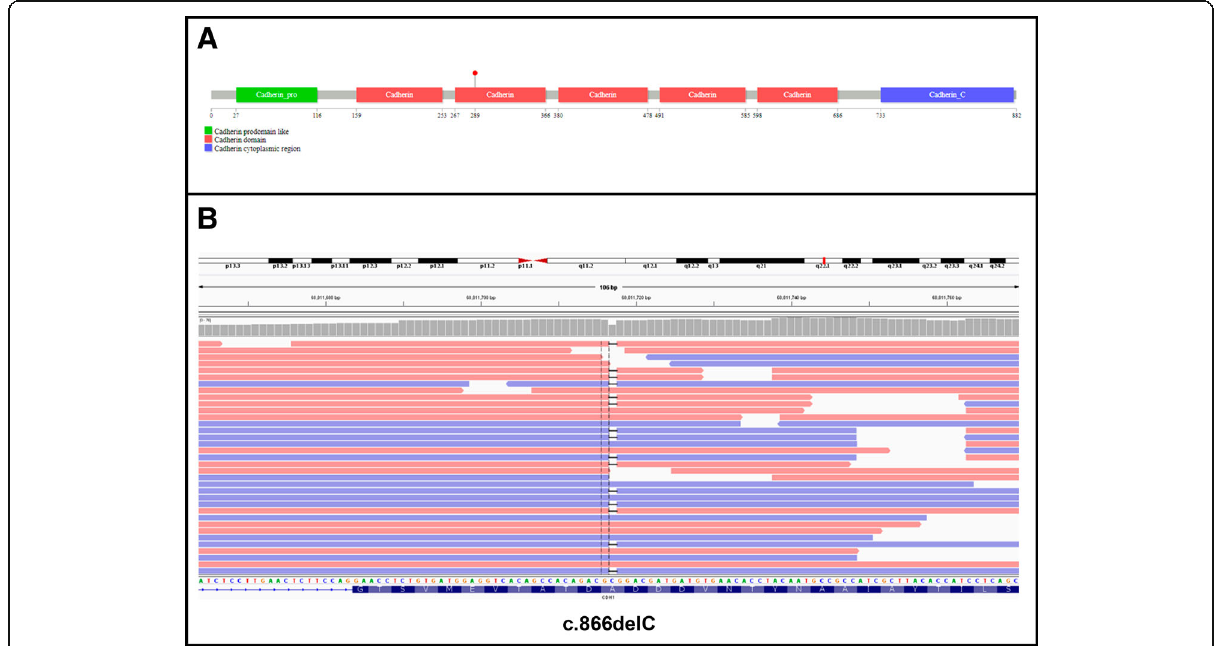
Fig. 3 Deleterious mutation in CDH1 found in the case studied. a Lollipop representation of deleterious mutation c.866delC in CDH1. E-cadherin motifs are represented in different colours. b IGV-browser view of mutation c.del866C through massive sequencing data from the case studied. Mutation is represented in both DNA strands (5 ′ - > 3 ′ , red, and 3 ′ - > 5 ′ , blue) in a high frequency of reads, supporting a homozygous status (through LOH) within tumour cells